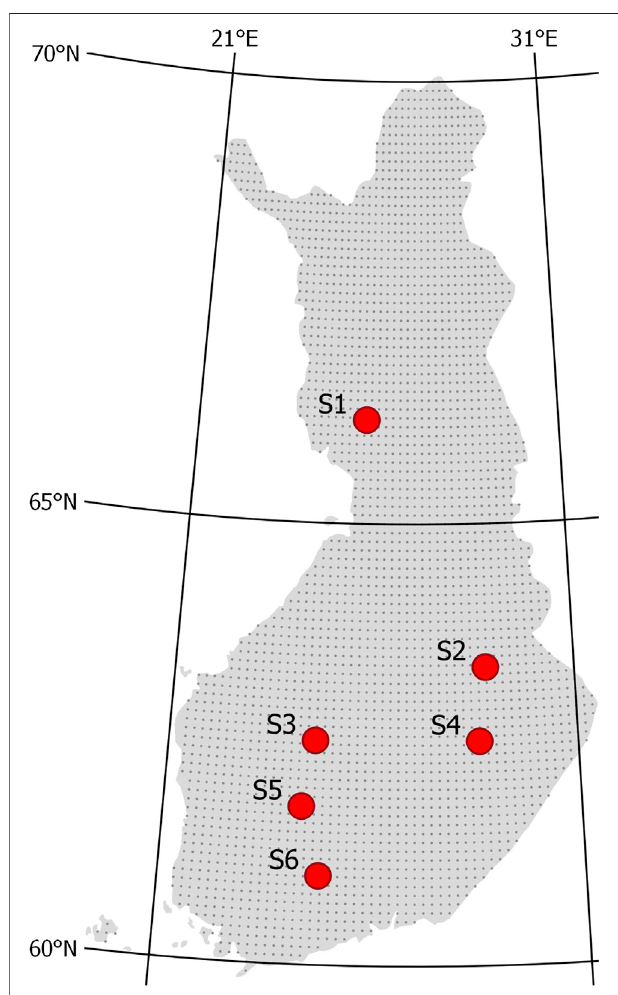
FIGURE 1 | Location of study sites S1 – S6 in Finland. Gray dots indicate resolution used in generalizing climate simulations (see section Scenario Simulations for Current and Future Climate